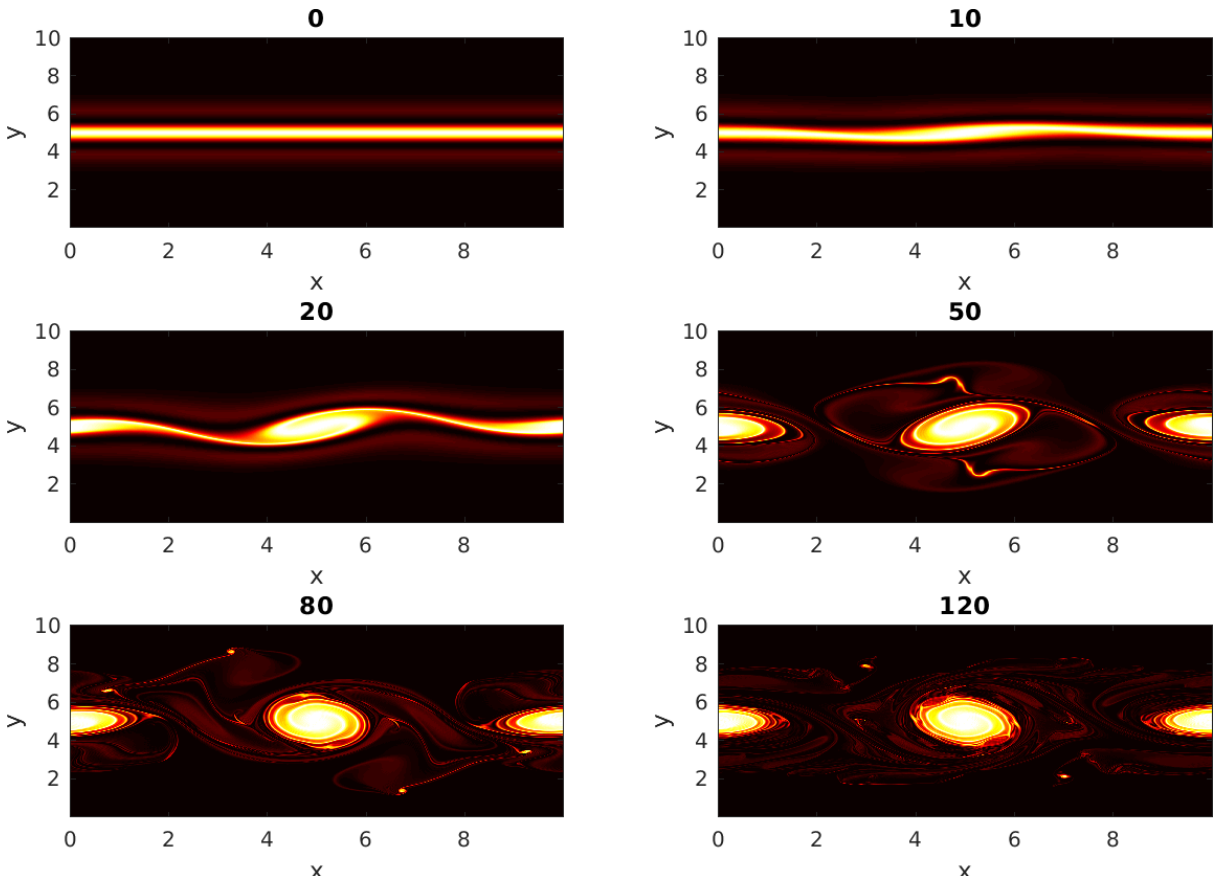
Figure 1. The enstrophy field showing the evolution of the unstable double jet with time. The bright areas indicate regions of high enstrophy which are found between the two jets at early